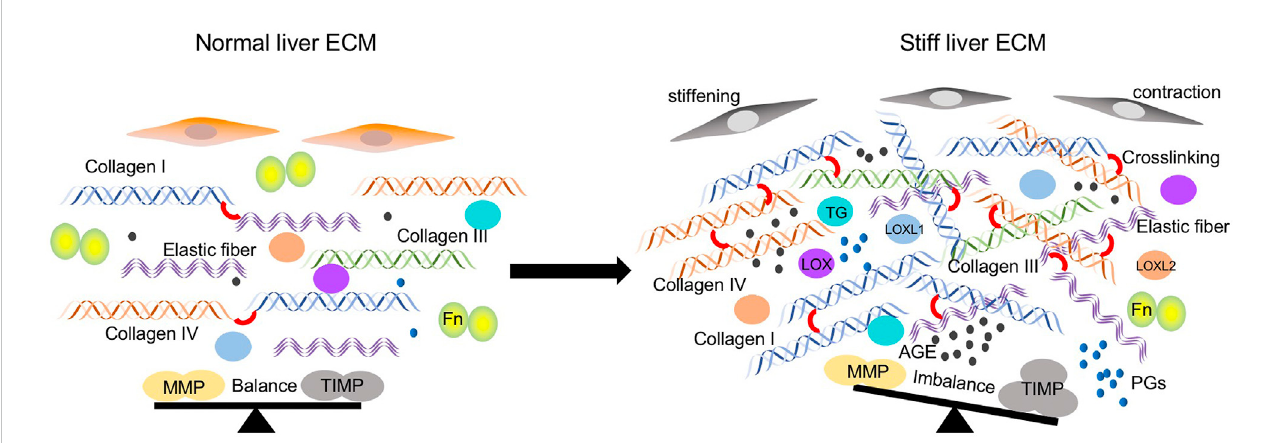
Regulators participated in ECM stiffening in the pathological lung tissues. ECM components including collagen type I, III, IV, and elastic fi bers are signi fi cantly increased. Crosslinking between ECM components is elevated caused by increased crosslinking enzymes such as LOX family, TGs, and non- enzymatic AGEs modi fi cations. The balance between MMPs and TIMPs is disturbed due to the increased expression of TIMPs and decreased MMPs. Cells stiffening and contraction also contribute to the matrix